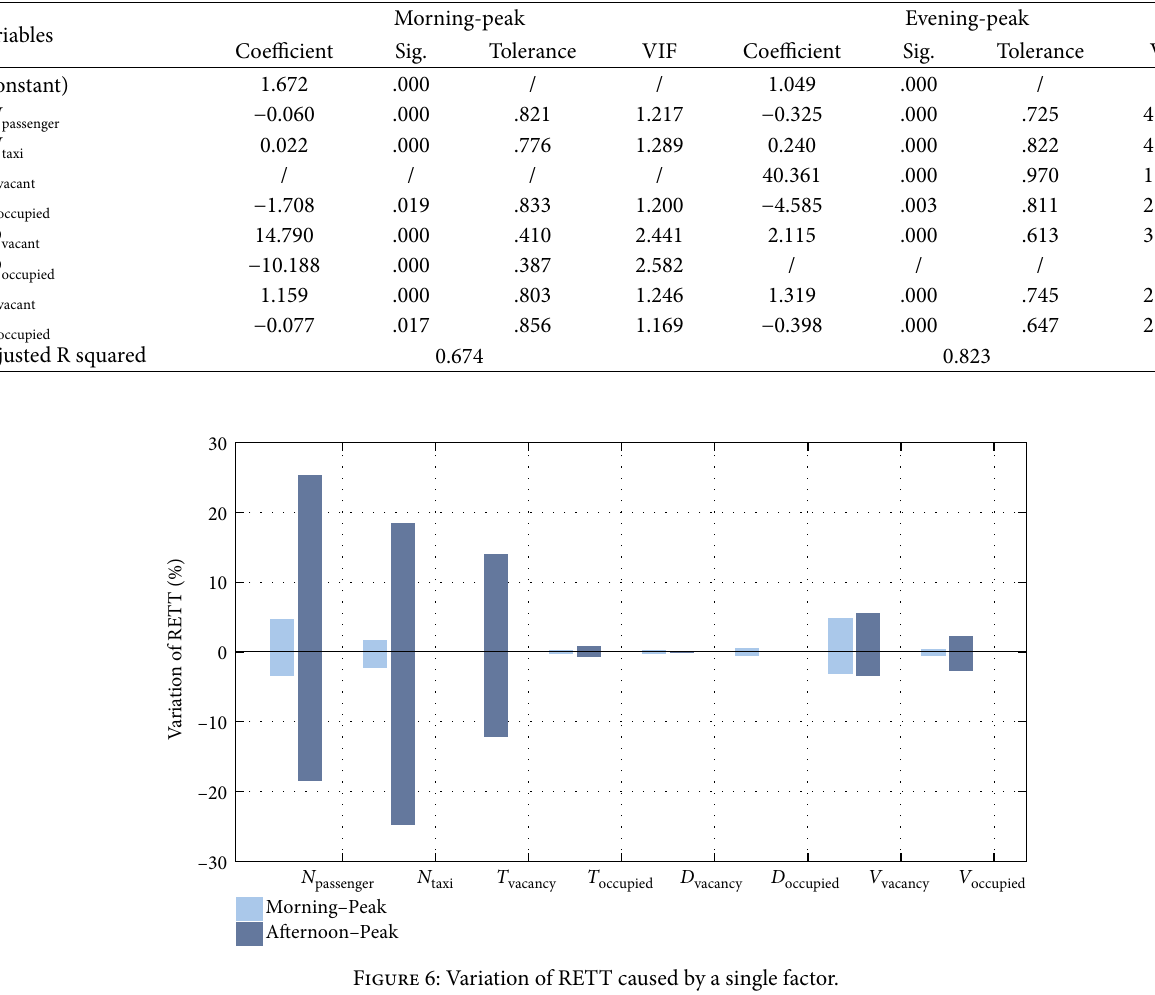
Table 5: Model results for peak hours.